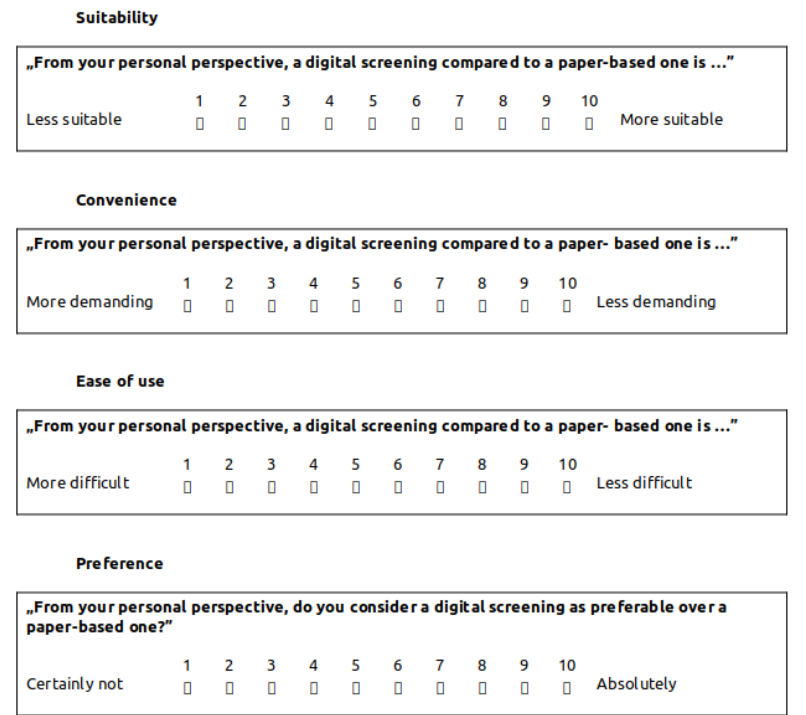
Figure 7. Questionnaire addressing the feasibility of the digital screening versus the paper-based one. Suitability, convenience, ease of use and preference of digital screening compared to paper-based screening are evaluated via this questionnaire. All questions can be answered on a bipolar likert-scale ranging from 1 to 10. Original questions are formulated in German, being translated to English for the sake of